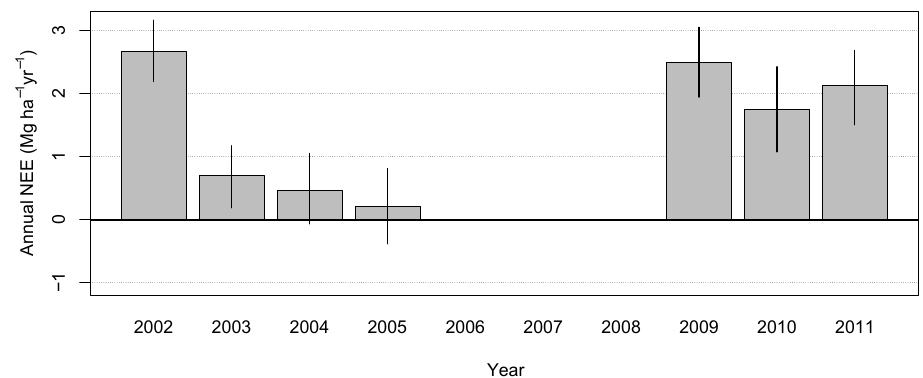
Figure 1. Annual sums of NEE in kgha − 1 yr − 1 . Error bars are 95% confidence intervals. Positive values indicate a source of CO 2 to the atmosphere. Net emission of carbon to the atmosphere during every year in the time series was possibly due to choice of u Th ∗ (Fig. S2 for annual NEE time series derived from an alternative choice of flux bias correction).